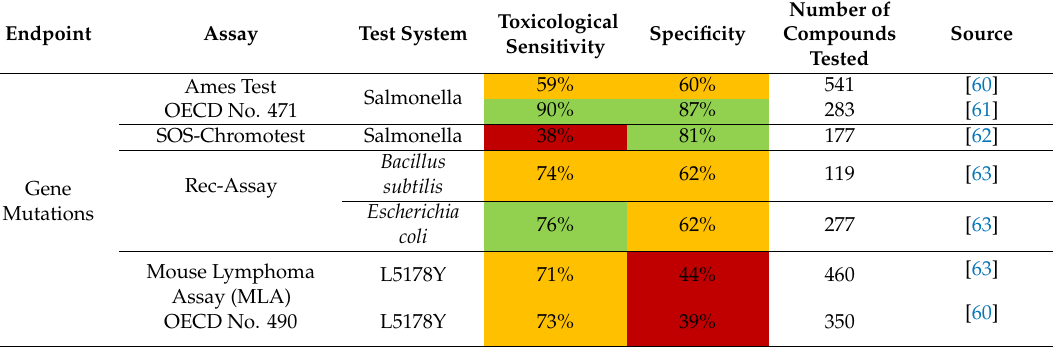
Table 1. Overview of toxicological sensitivity and specificity of the most commonly used mammalian in vitro assays for the detection of genotoxicity. Values highlighted in green show a high ( > 75%), in orange a moderate (75% to 50%), or in red a low ( < 50%) toxicological sensitivity or specificity. The term toxicological sensitivity refers to the proportion of genotoxic substances correctly identified as positive in the assay. The specificity describes the substances correctly identified as negative in a pool of non-genotoxic substances